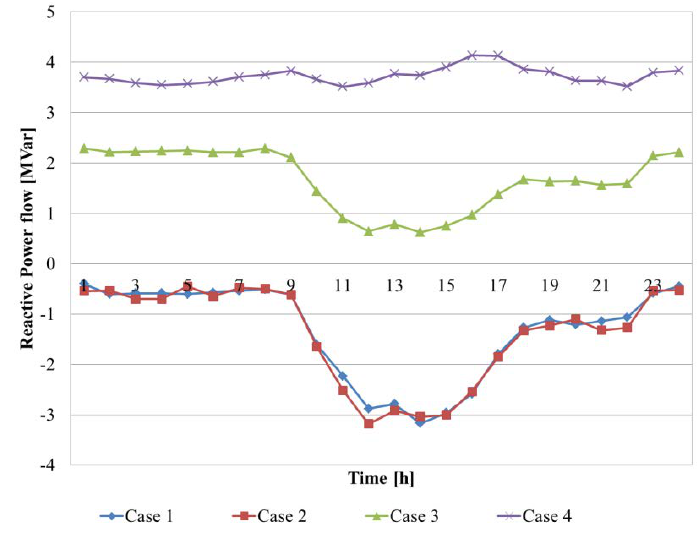
Figure 12. Reactive power flow of line 10 (bus 11 to bus